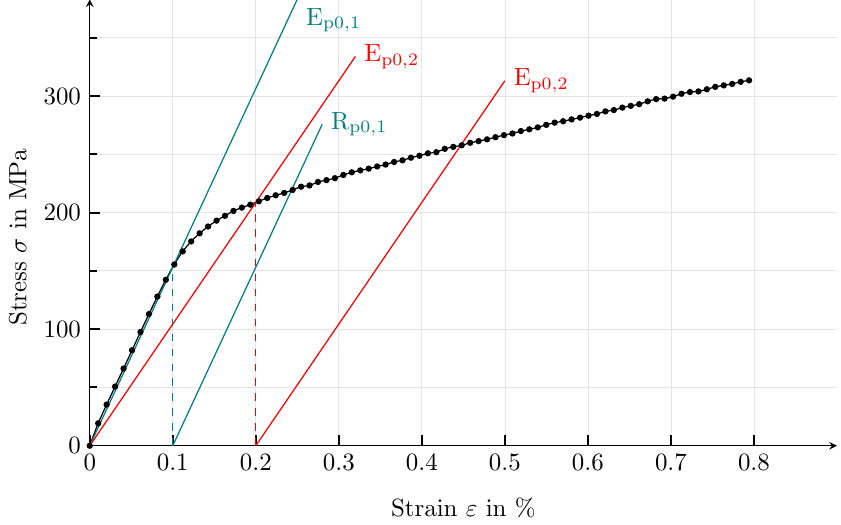
Figure 21. Schematic evaluation of the secant module and the yield strength. The secant moduli are evaluated at strains of 0.1% and 0.2%. The straight lines for evaluating the yield strengths, R p , run parallel to the Young’s